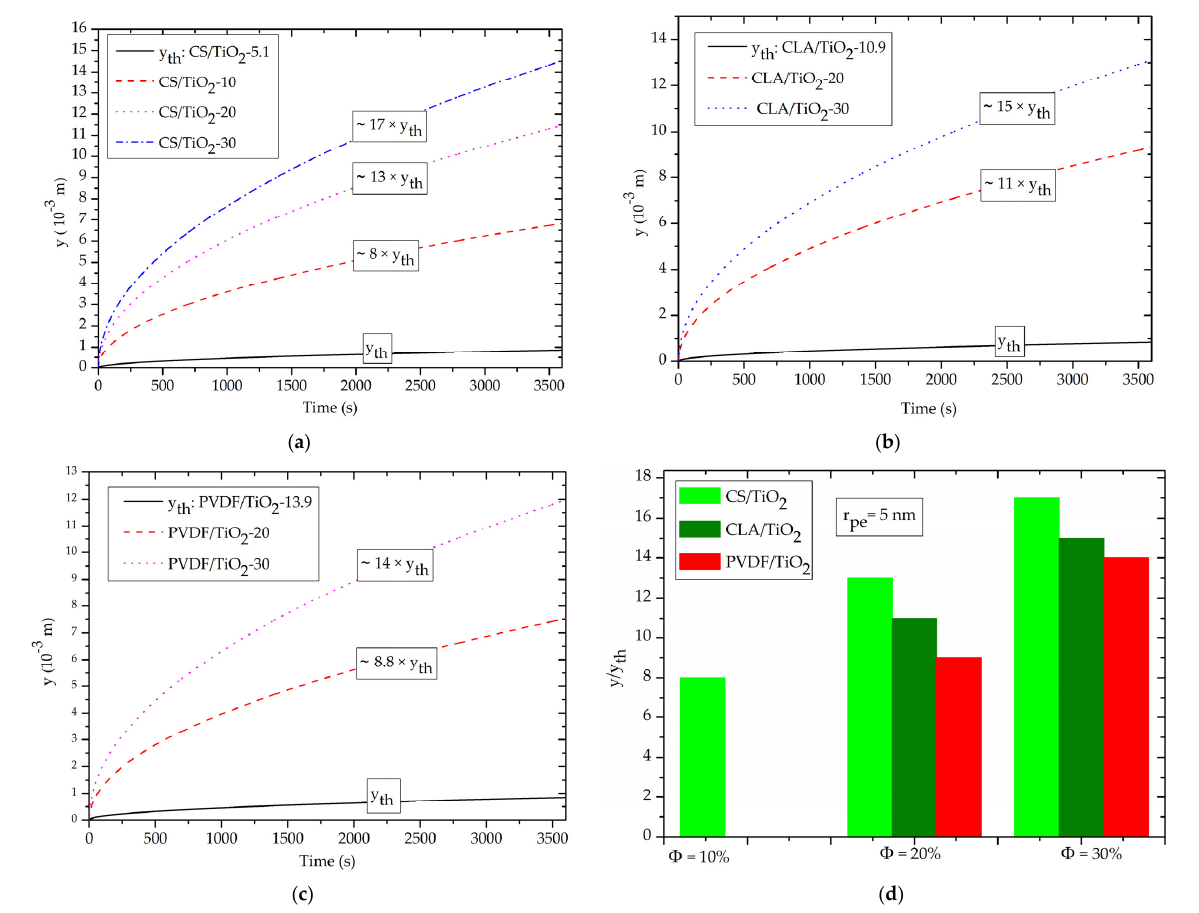
Figure 7. Effect of the volume fraction of TiO 2 NPs on capillary rise y(t) with r pe = 5 nm: ( a ) CS/TiO 2 , ( b ) CLA/TiO 2 , ( c ) PVDF/TiO 2 , ( d ) y/y th as function of Ф of TiO 2 NPs.